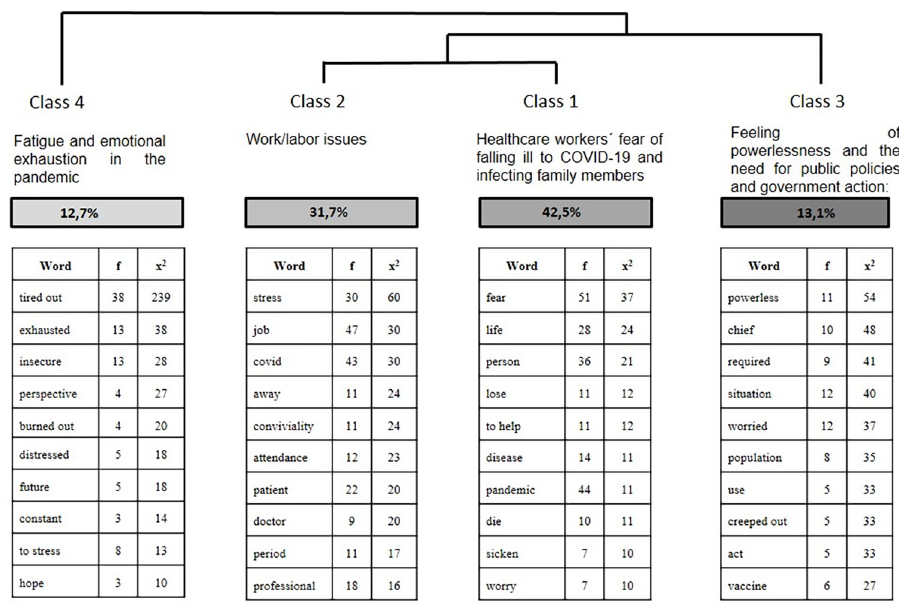
Downward hierarchical classification The classes received headings according to the meaning of their TS presented according to the dendrogram´s division Fig 2. The dendrogram thus obtained: Class 1: Healthcare workers´ fear of falling ill to COVID-19 and infecting family members, corresponding to 42.48% of the TS and 240 words; Class 2: Work/labor issues: totaled 31.68% of the TS, with 179 of the analyz- able words; Class 3: Feeling of powerlessness and the need for public policies and government action: totaled 13.1% of the TS, with 74 words; and Class 4: Fatigue and emotional exhaustion in the pandemic: classified 72 words in class 4, with 12.7% of the TS.